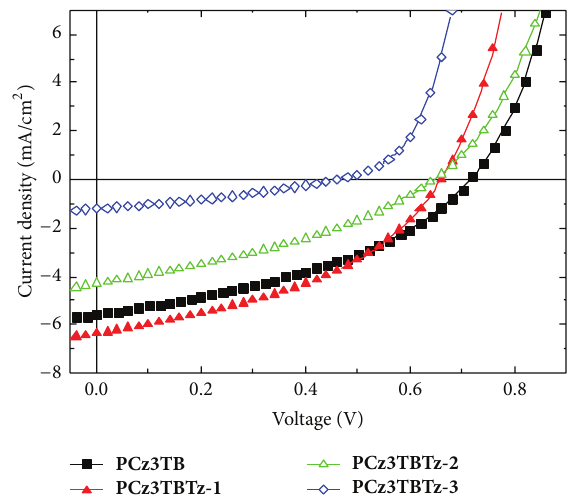
Figure 4: J - V curves of photovoltaic cells of copolymers.